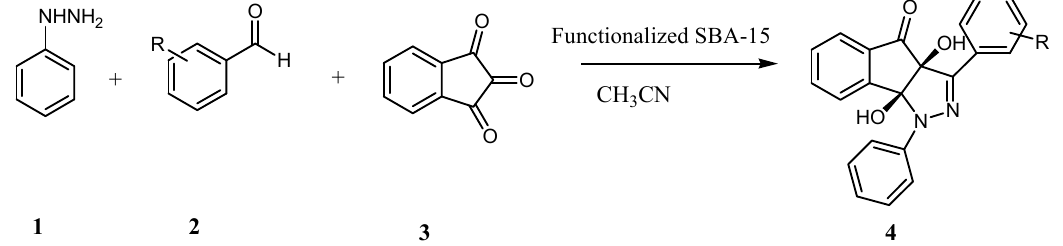
Scheme 1. Synthesis of indenopyrazolones catalyzed by Functionalized SBA-15